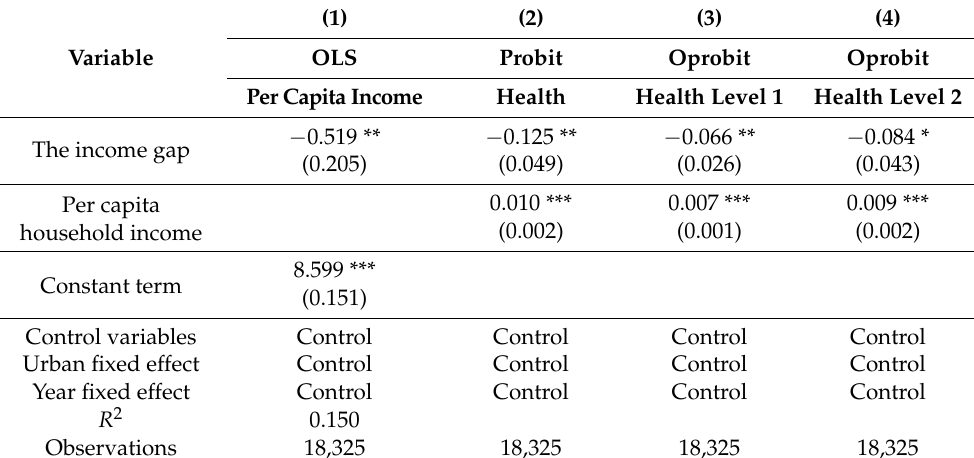
Table 9. Income gap, household income level, and health level of rural residents.